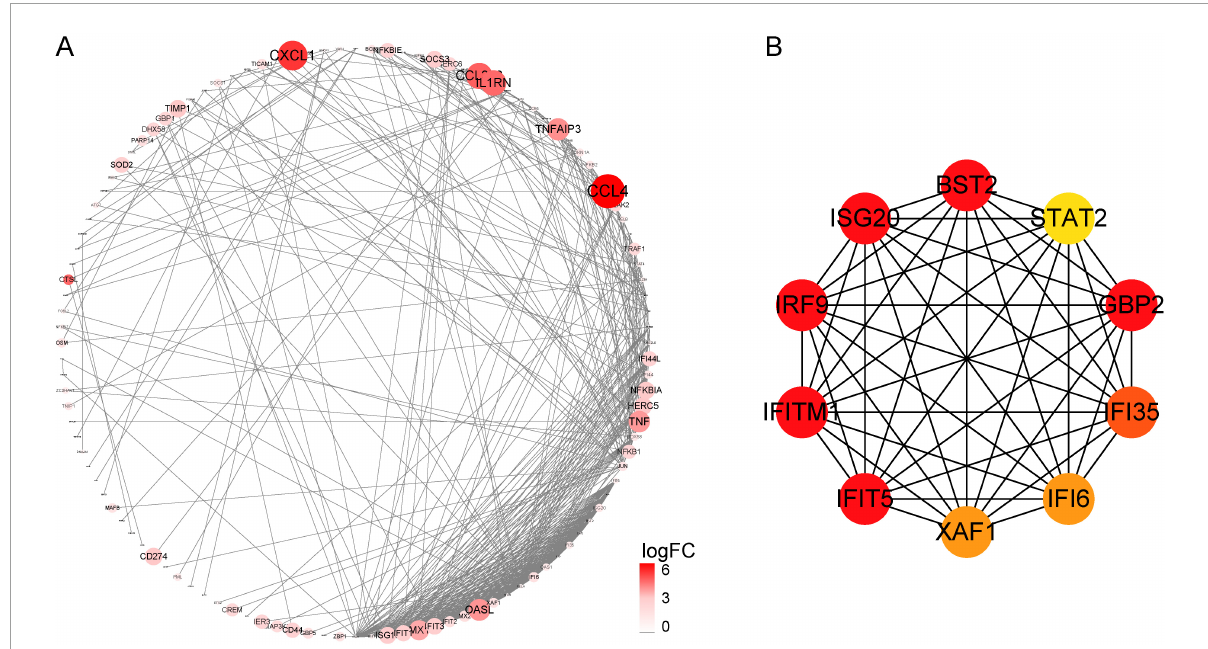
FIGURE3 (A) Protein-protein interaction network of DEGs constructed using cytoscape. (B) The top 10 hub genes were explored using